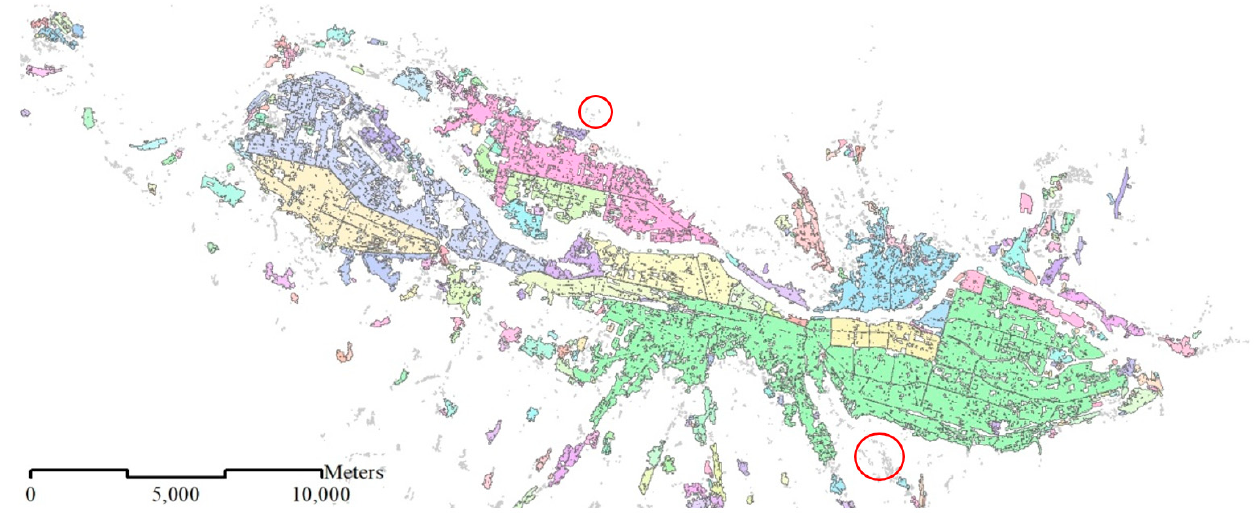
Figure 10. Buffering results (20 m) of 1:10K buildings.